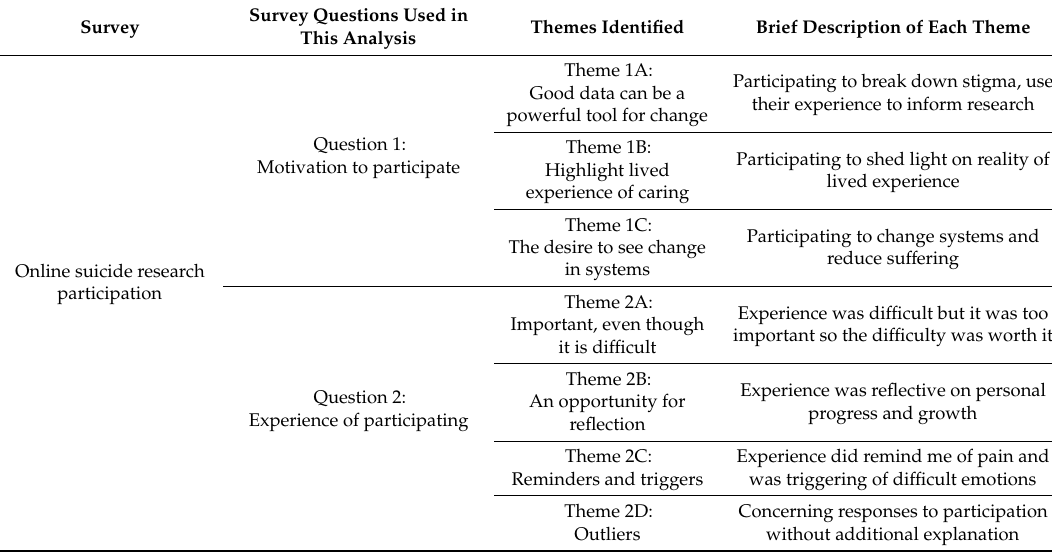
Table 2. Overview of